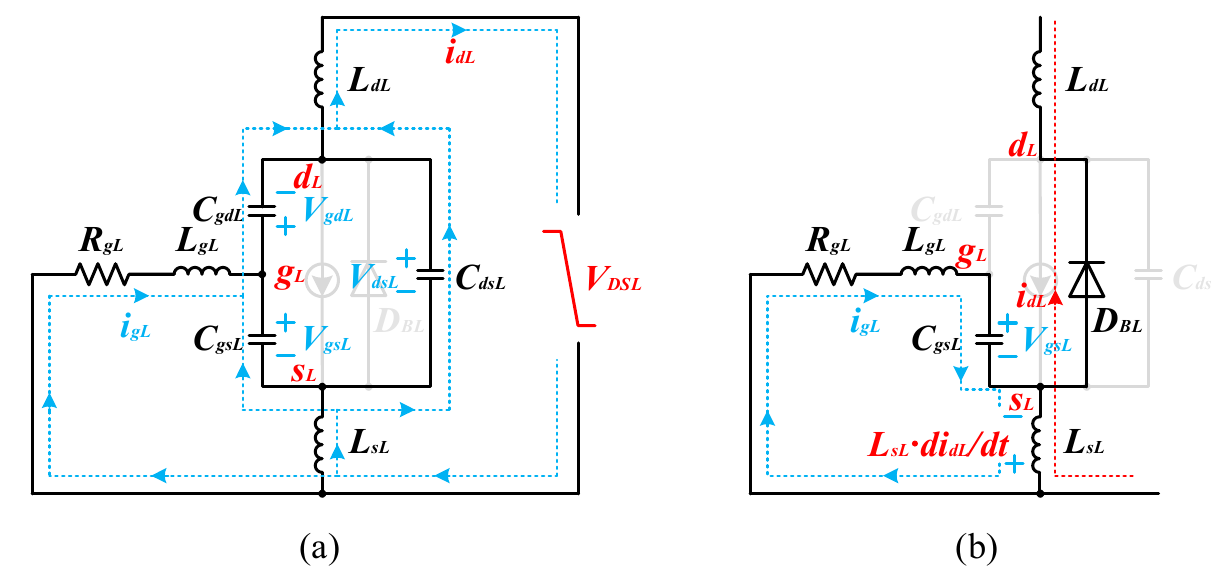
Figure 5. Equivalent circuit of Q L for crosstalk analysis during turn-off process. ( a ) voltage drop stage. ( b ) current rise stage.